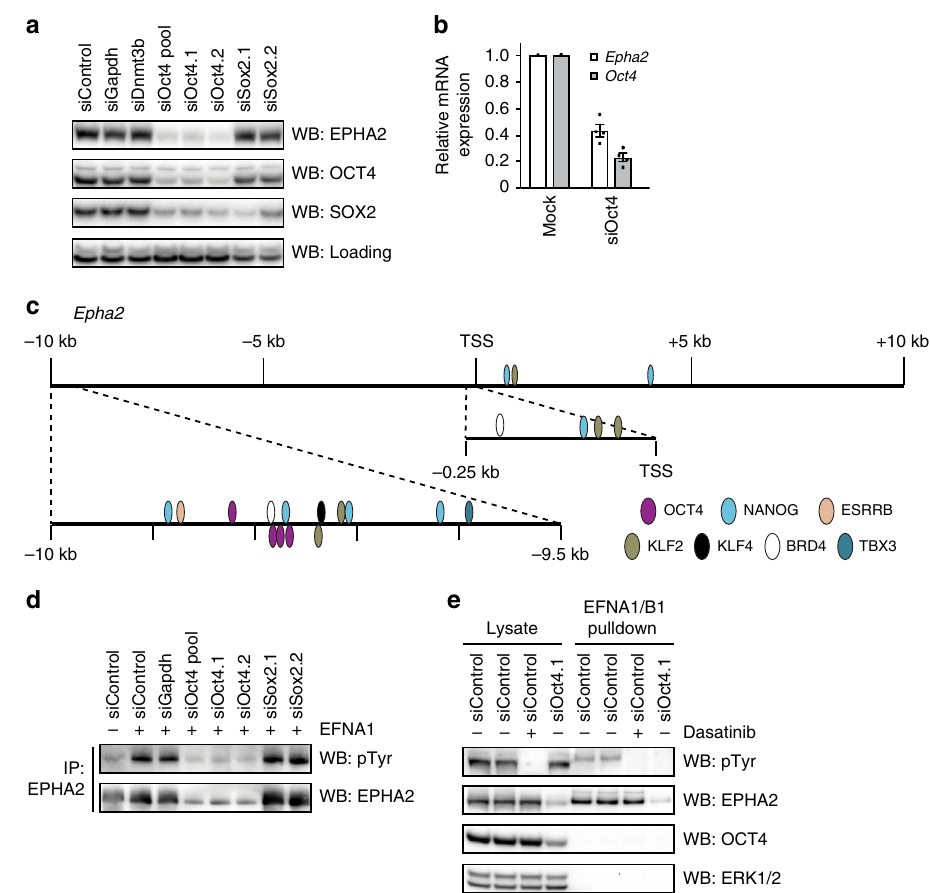
Fig. 5 OCT4 is required for EPHA2 expression and EFN ligand responses in mESCs. a Epha2 + / + mESCs were transfected with the indicated siRNAs, and EPHA2, OCT4 and SOX2 levels determined by immunoblotting. A non-speci fi c band was used as a loading control. b Epha2 and Oct4 mRNA expression was determined by qRT-PCR following transfection of Epha2 + / + mESCs with control or OCT4 siRNA. Data show mean ± SEM of four technical replicates (n = 4). c Pluripotency transcription factor-binding sites in Epha2 gene regulatory regions were extracted from CODEX mESC ChIP-SEQ data (http:// codex.stemcells.cam.ac.uk). d Epha2 + / + mESCs were transfected with the indicated siRNAs, and stimulated with 1 μ g/ml clustered EFNA1 for 15 min. EPHA2 was immunoprecipitated using EPHA2 antibody, and pTyr and EPHA2 levels determined by immunoblotting. e EFNA1/B1 af fi nity puri fi cation from control, dasatinib-treated or siOct4-transfected mESCs. pTyr, EPHA2, OCT4 and ERK1/2 levels were determined by immunoblotting. Source data are provided as a Source Data fi